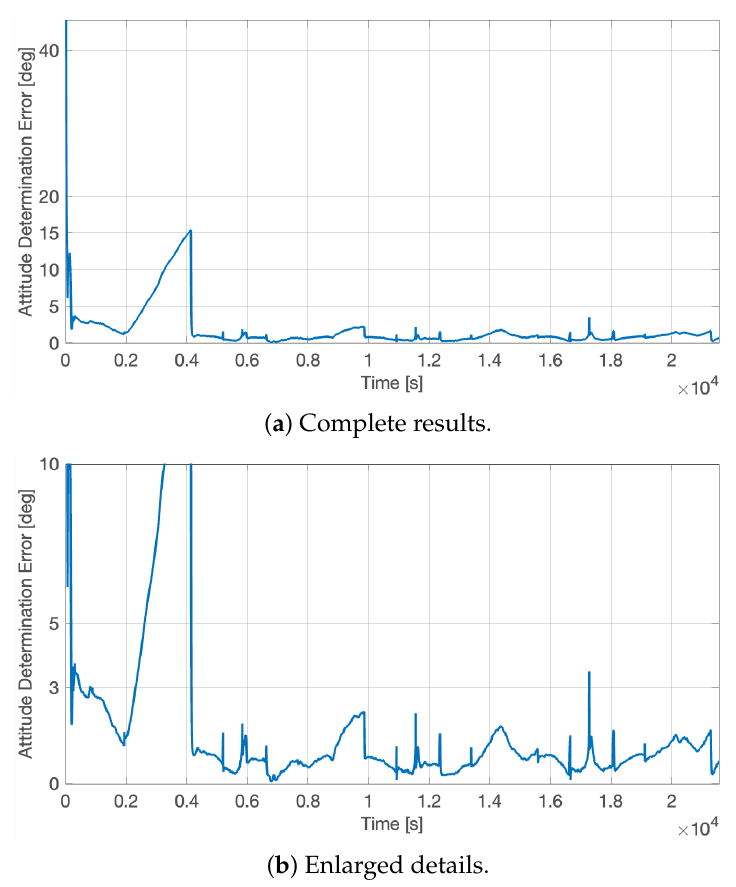
Figure 14. Full-attitude determination error, α err , in nadir-aligned attitude